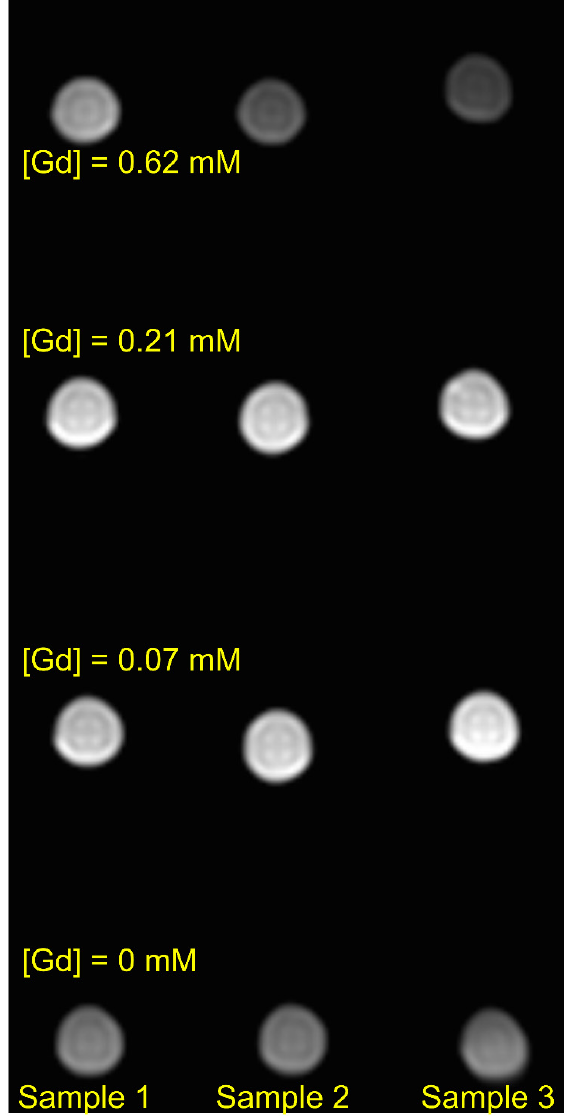
Figure 15. Combined T 1 - and T 2 -weighted image of a cross section of the phantom described in the text. To obtain the image, a T2-TSE pulse sequence was used on a 3 T Philips Ingenia human MRI scanner with parameters TR = 2000 ms and TE = 200 ms, (the inversion pulse was not applied). Other parameters of the experiment were: 16-channel head coil for the radiofrequency (RF)-pulse application and detection of proton free induction decay, voxel size 0.5 × 0.5 × 10 mm 3 , size of image matrix 160 × 160.